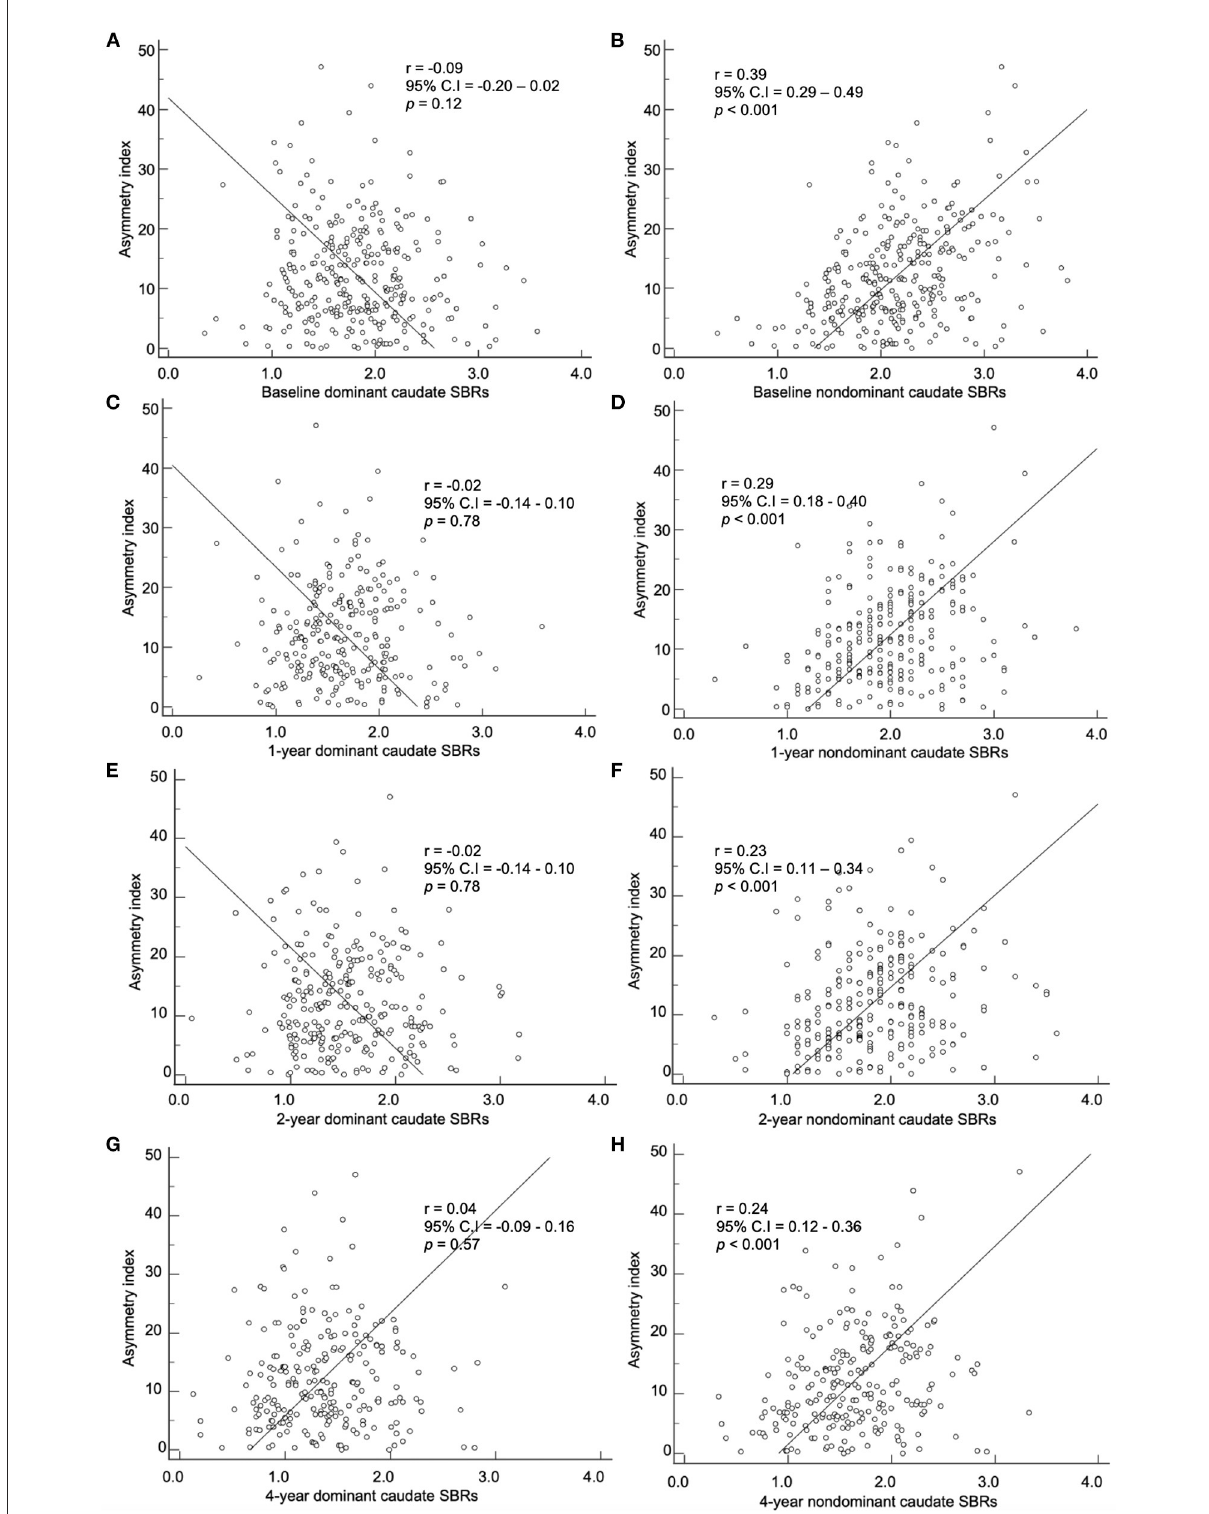
FIGURE4 Correlation of the baseline asymmetry index of the caudate by method 2 with SBRs of (A) baseline, (C) 1-year, (E) 2-year, and (G) 4-year. Correlation of the baseline asymmetry index of the caudate by method 2 with SBRs of (B) baseline, (D) 1-year, (F) 2-year, and (H)